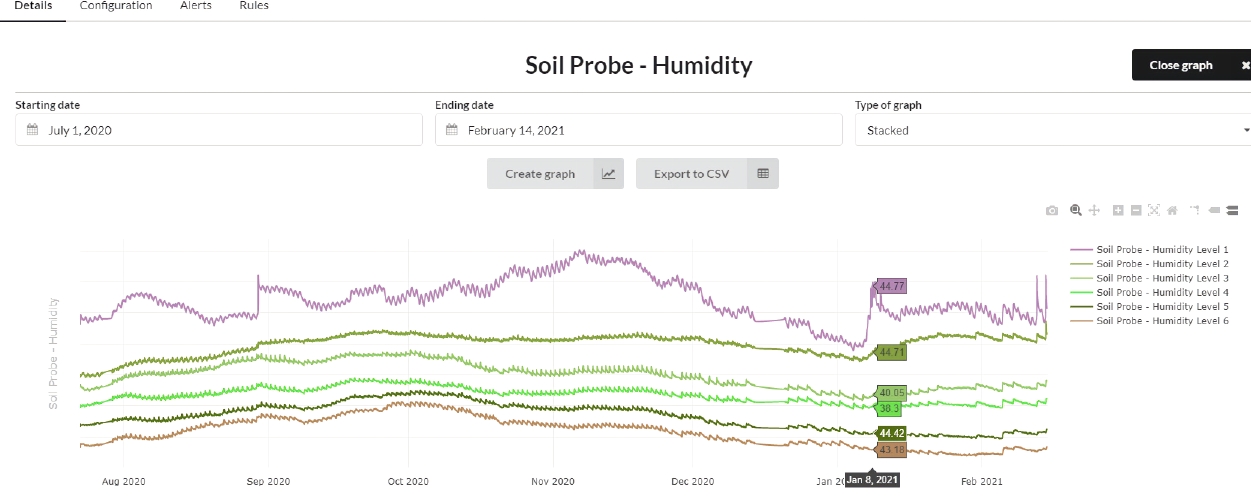
Figure 11. Representation of different soil moisture levels in a peach plot to monitor water